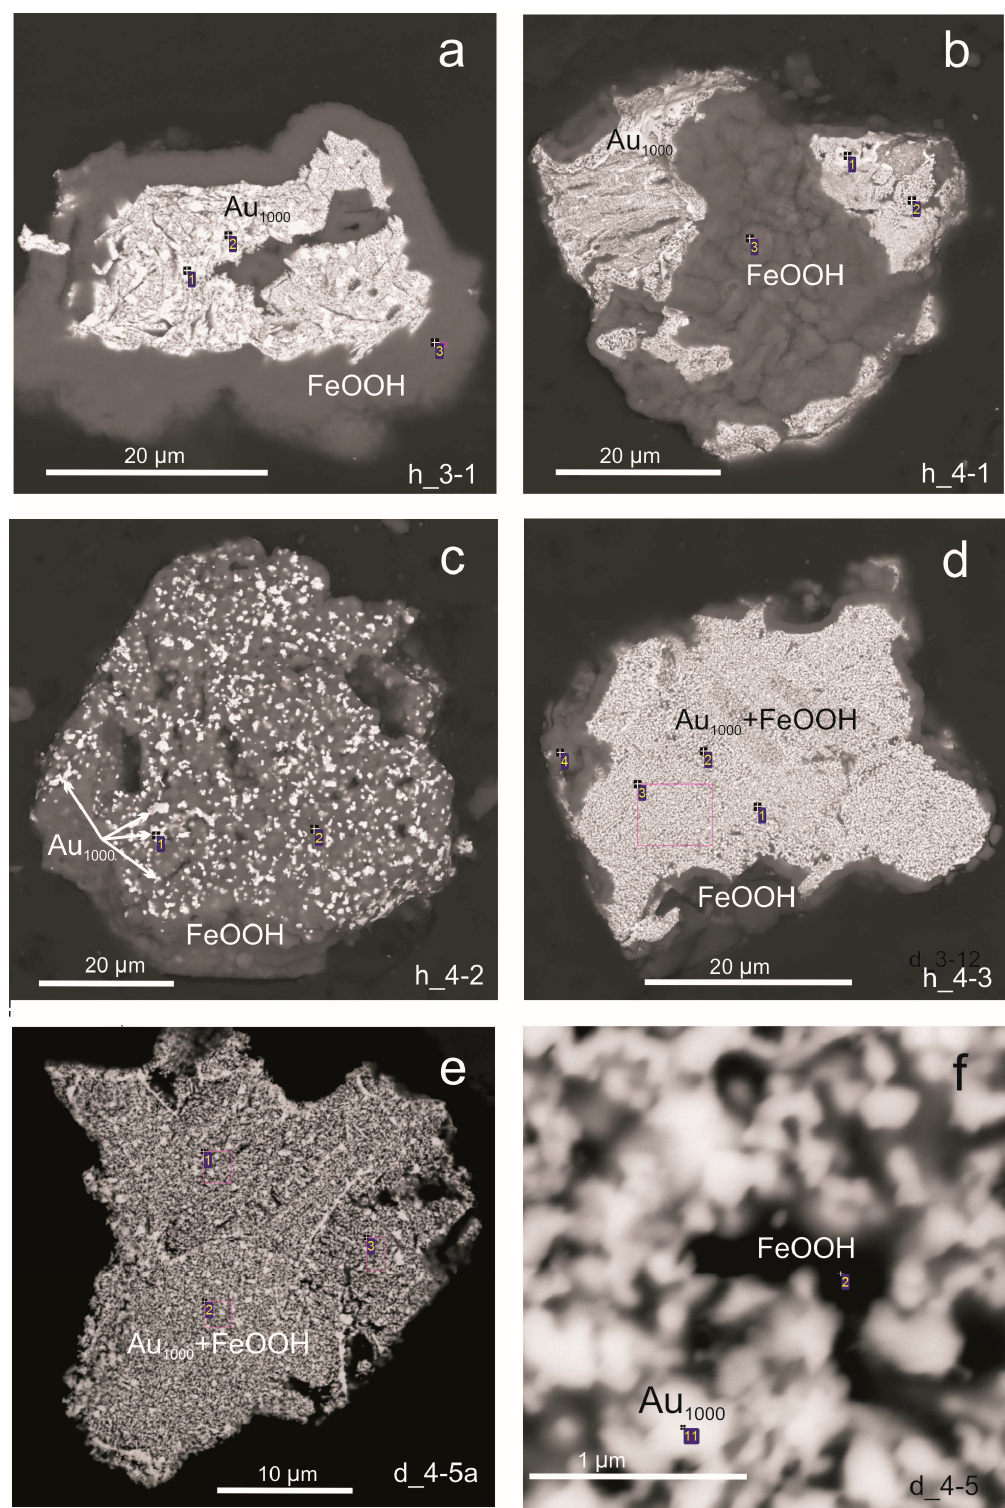
Figure 6. SEM image of mustard gold of colloform ( a , b ) and spotted ( c – f ) textures intergrown with goethite/hydrogoethite/limonite (FeOOH). The compositions of compounds and mixtures of the minerals are presented in Table 5. The purple square is scan analytical area.